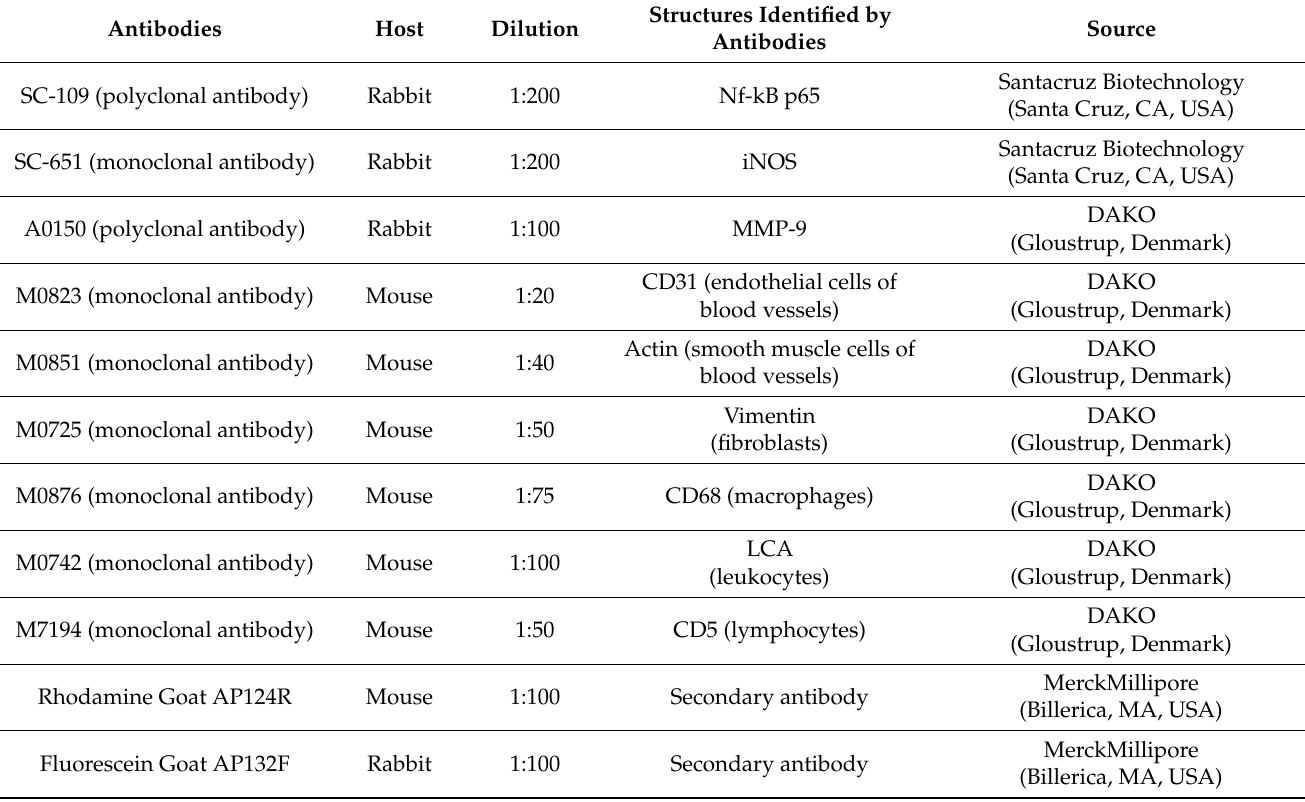
Table 2. Primary and secondary antibodies